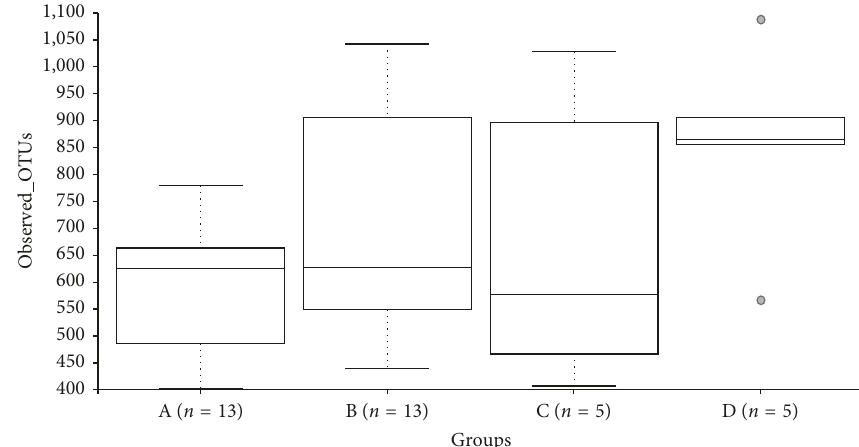
Figure 3: Observed OTUs boxplot and Kruskal–Wallis pairwise comparisons.